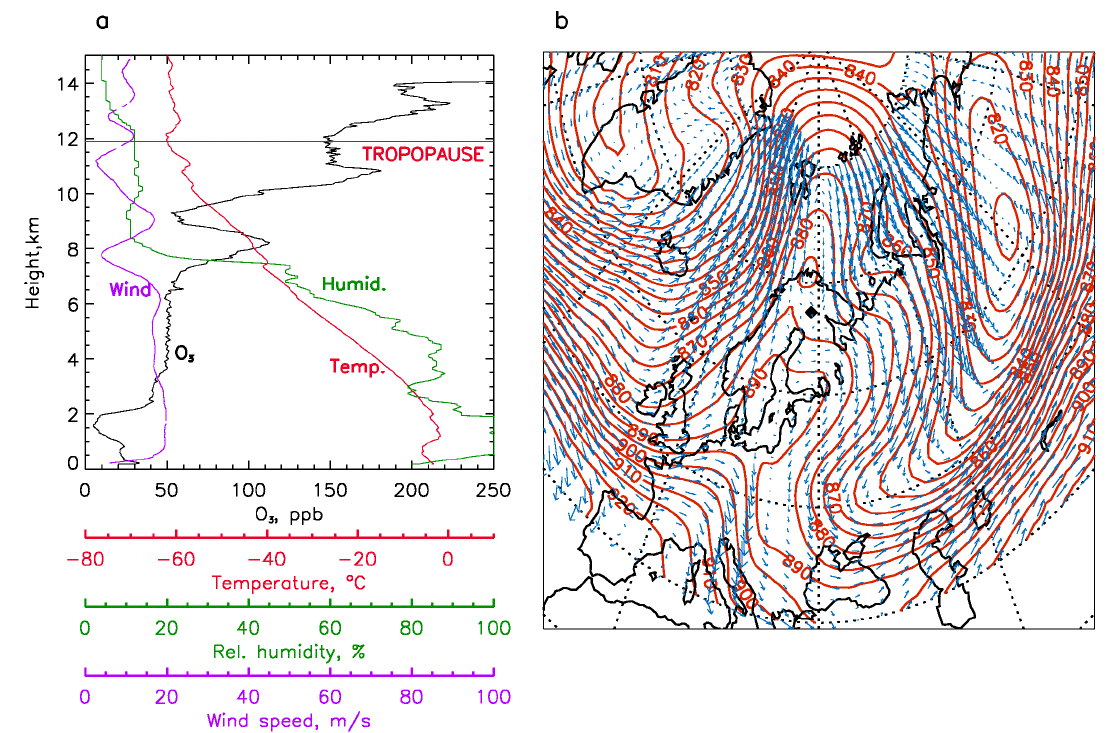
Fig. 1. (a) Sodankyl¨a profiles of ozone, relative humidity, temperature and wind speed at 12:00UTC on 10 November 1993 and (b) 300hPa geopotential height (decameters) at 12:00UTC on 10 November 1993. Superimposed are wind vectors. Sodankyl¨a is marked with a